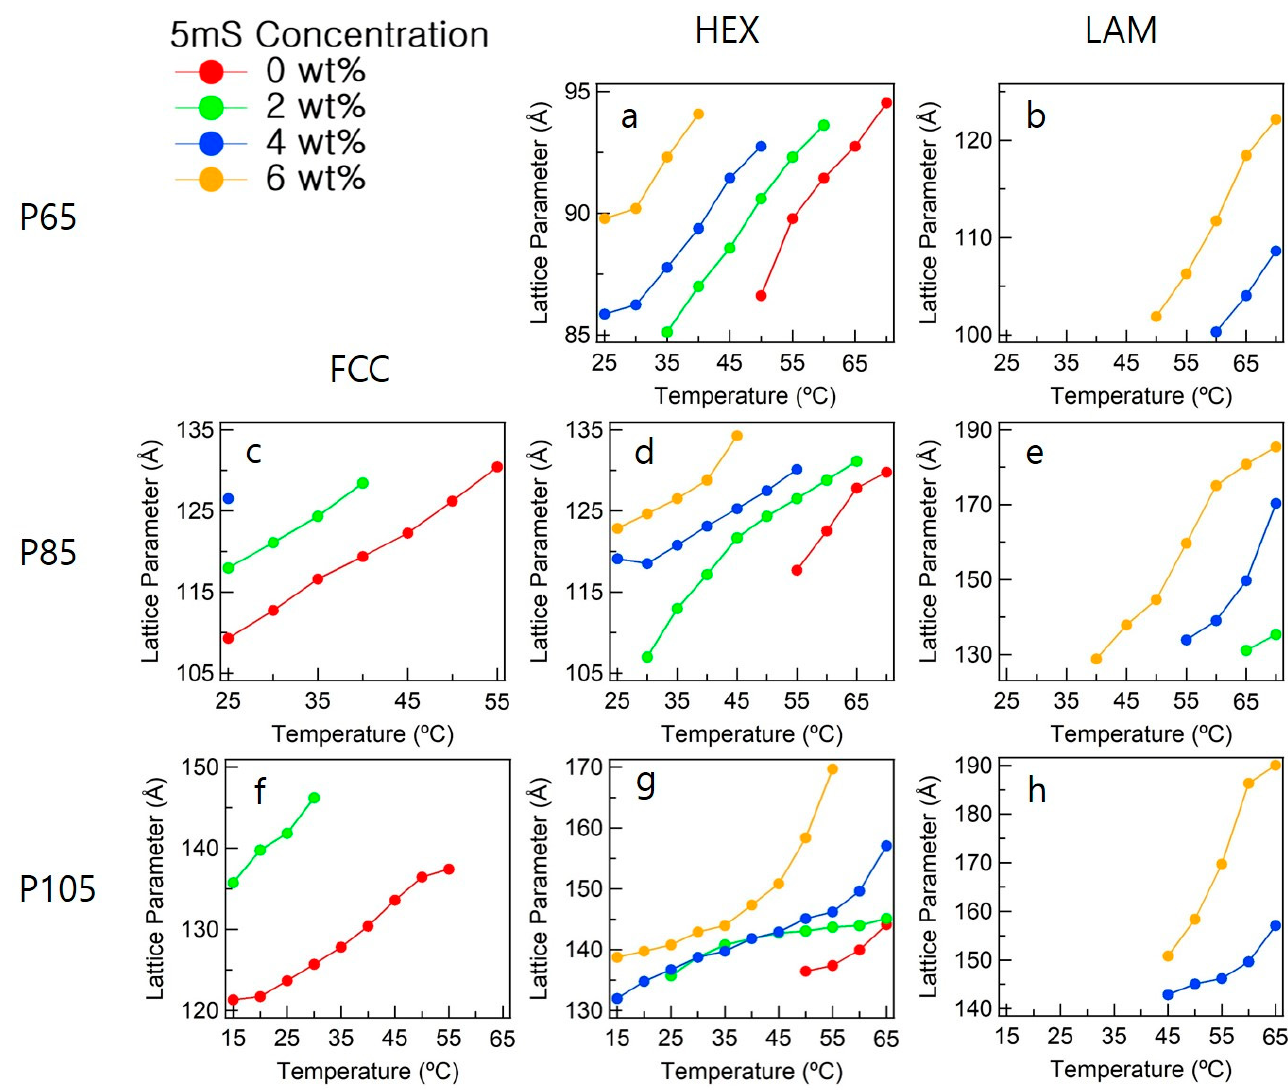
Figure 5. Lattice parameters of P65-5mS, P85-5mS, and P10-5mS complexes. The inter-planer distances of D 100 distances of ( a ) Hexagonal and ( b ) lamellar of P65-5mS complex, a d 111 distance of ( c ) FCC of P85-5mS complex, d 100 distances of ( d ) Hexagonal and ( e ) lamellar of P85-5mS complex, a d 111 distance of ( f ) FCC of P105-5mS complex, and d 100 distances of ( g ) Hexagonal and ( h ) lamellar of P105-5mS complex displayed varied on a 5mS concentration, respectively.